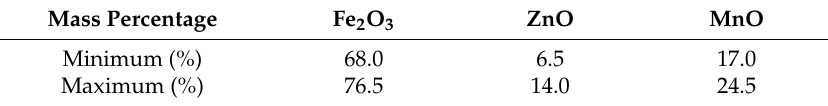
Table 3. Material mass composition percentage of MnZn soft ferrites.